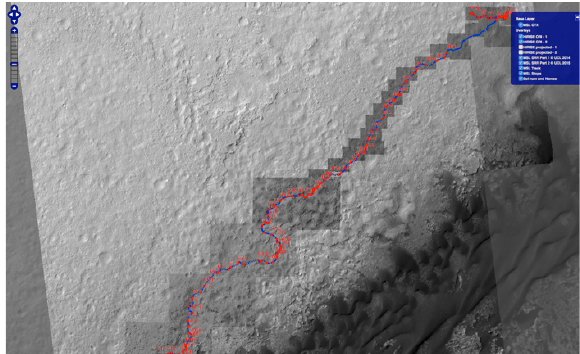
Figure 4 PRoGIS 1.0 interface showing MSL SRR products on the top of co-registered HiRISE and CTX orthoimage.